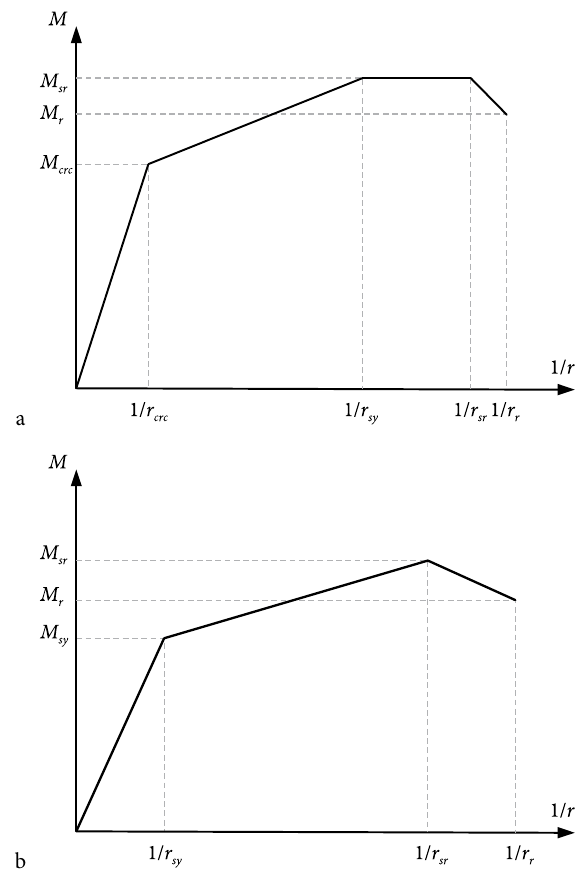
Fig. 1. Bending moment–curvature relationship when reinforcement is with definite yield point (a) and without definite yield point (b)